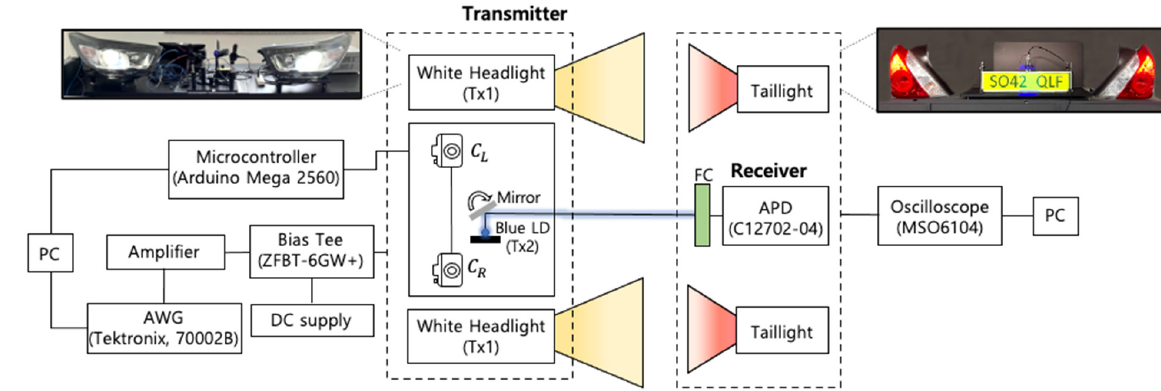
Figure 3. Schematic block diagram and experimental setup of the proposed V2V-VLC system.